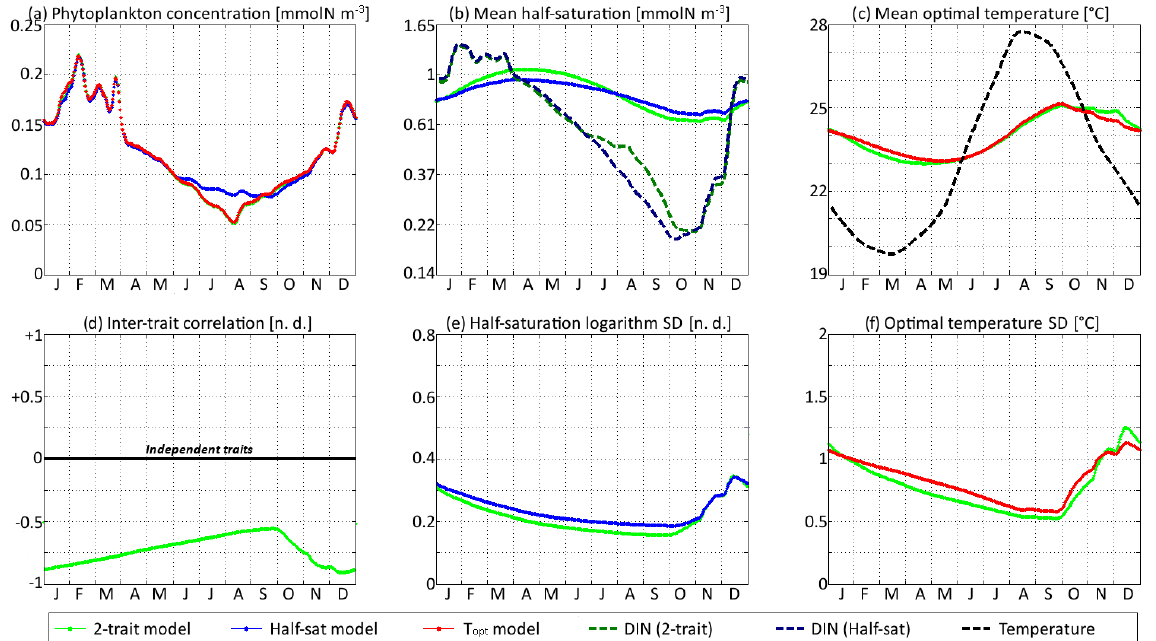
Figure 10. SPEAD state variables at the surface for ν x = 0.00001 and ν y = 0 . 0001 ◦ C 2 (low mutation rates) compared with the state variables of one-trait models: (a) total phytoplankton concentration, (b) (geometric) mean half-saturation, (c) mean optimal temperature, (d) inter-trait correlation, (e) half-saturation logarithm standard deviation, and (f) optimal temperature standard deviation. The dashed lines represent the environmental